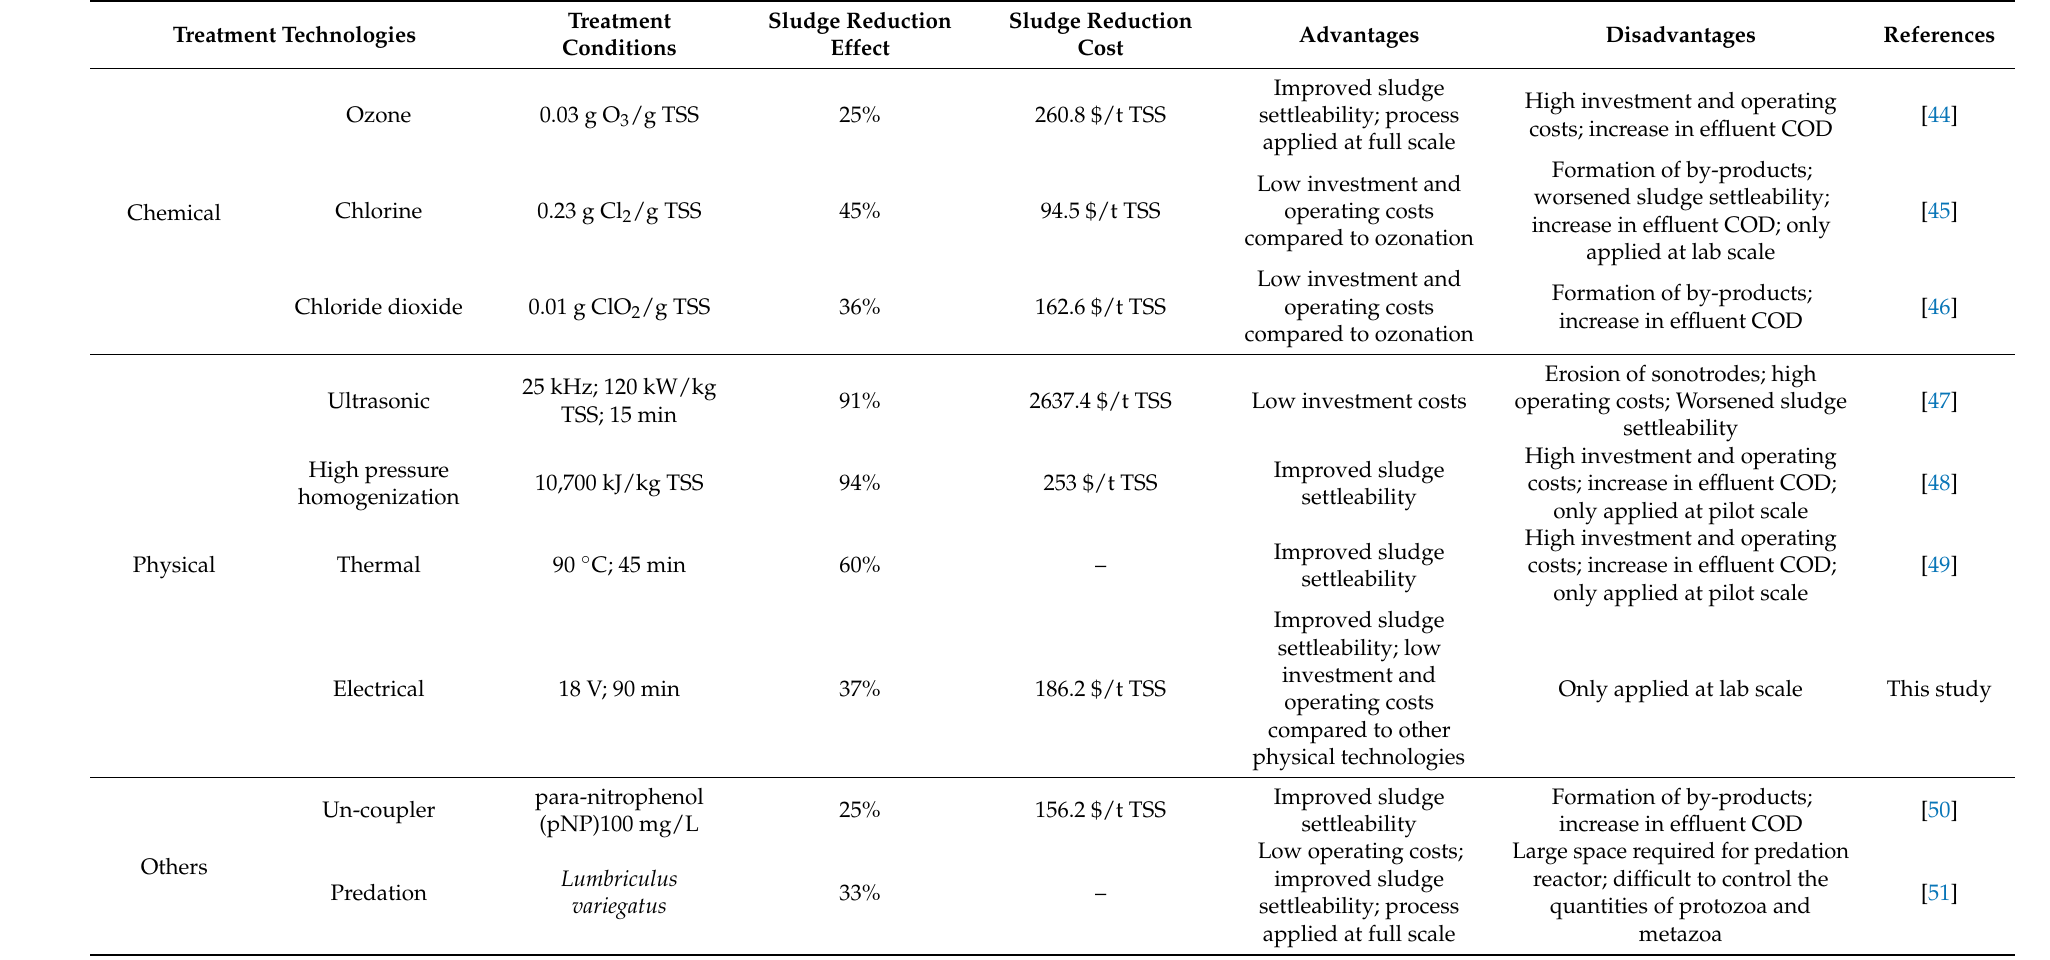
Table 2. Effectiveness and treatment cost of sludge reduction technologies applied in wastewater